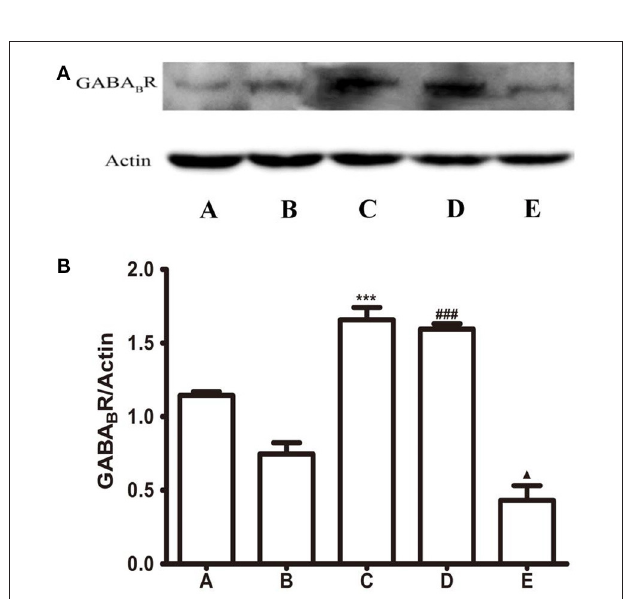
FIGURE 4 | Protein expression of GABA B receptor in the LHA. (A) Western blot analysis of expression of GABA B receptor. (B) Quantitative analysis of GABA B receptor expression in the LHA. β -Action was used as a loading control. *** P < 0.001, as compared with the GI-R group; ### P < 0.001, as compared with the GI-R group; N P < 0.05, as compared with the GI-R group. A, Normal group; B, GI-R group; C, FN + GI-R + L -Glu group; D, LHA + GI-R + Baclofen group; E, LHA + GI-R + CGP35348 group. n = 5.